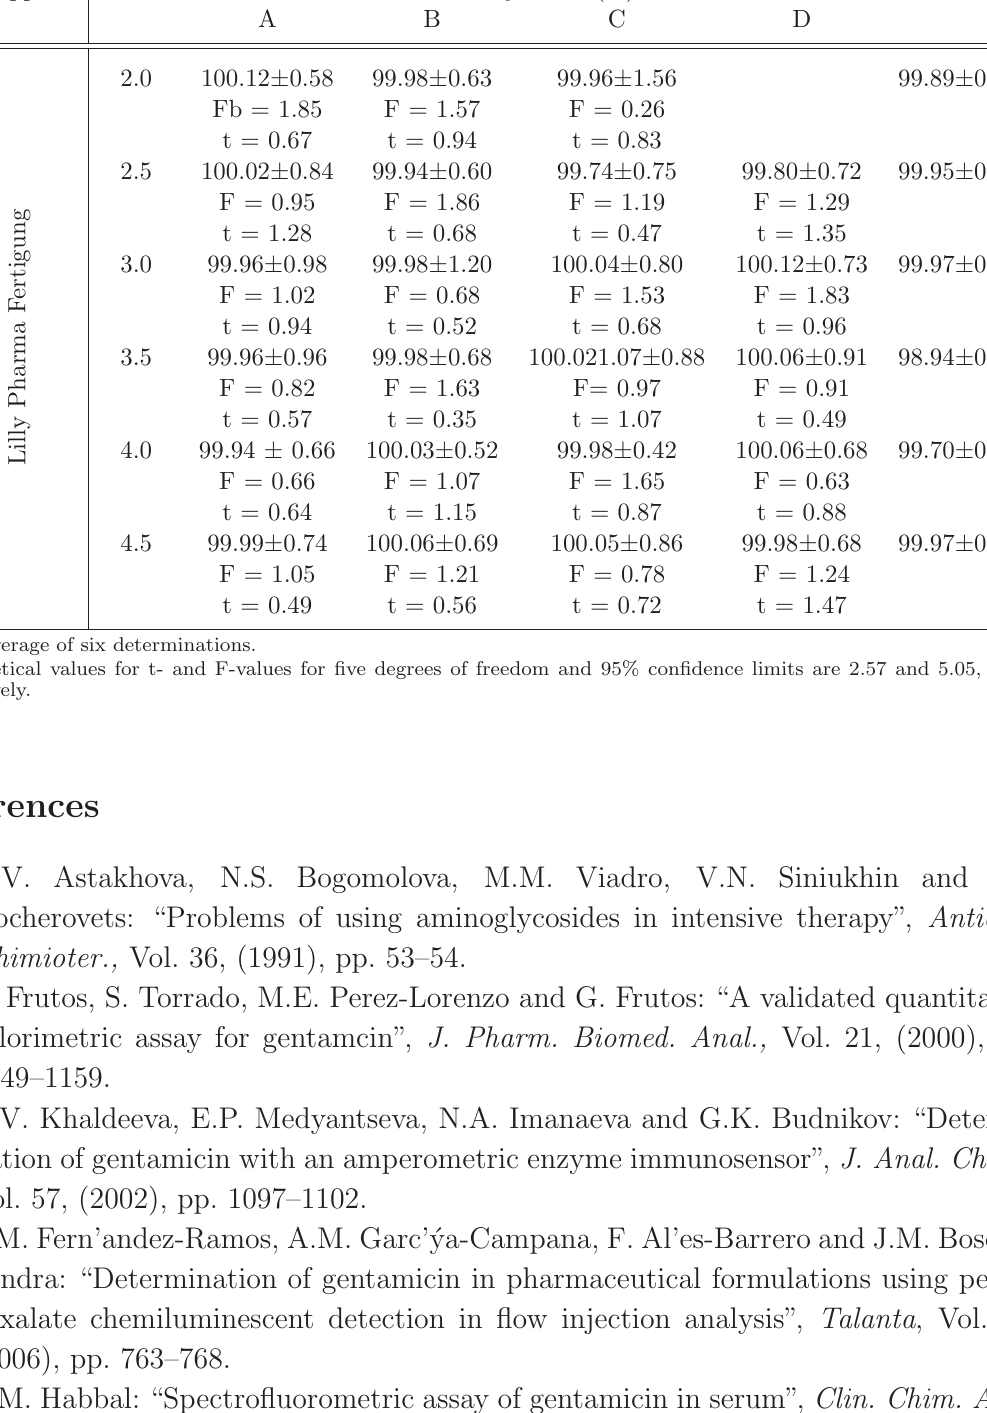
Table 7 Determination of vancomycin hydrochloride in vancocin pharmaceutical prepa- ration using the proposed methods.